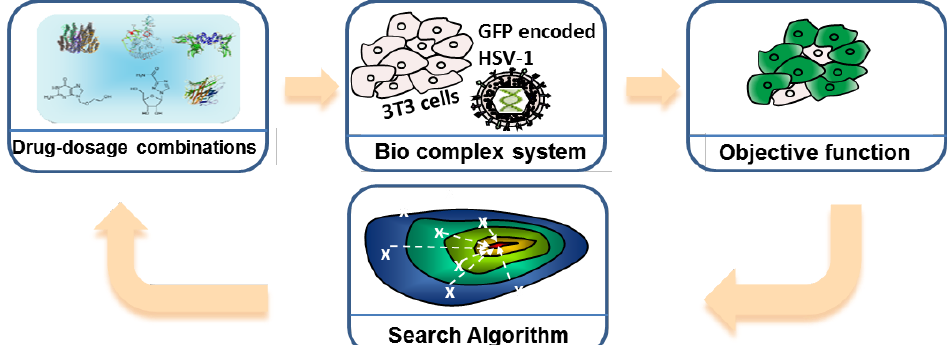
Figure 7. Feedback system control (FSC) scheme applied to the optimization of an Herpes Virus Simplex 1 (HSV-1) viral infection drug treatment. Drug combinations serve as the input stimuli for the biological complex system, the infected 3T3 cells; the virus attempts to infect normal cells, and the drug combinations try to inhibit virus infection. The objective function, or output, measures the efficiency of the drug combination. The search algorithm reads the output and suggests new drug combinations to be tested, and these combinations improve with each iteration, leading to fewer infected cells. Adapted with permission from [23,24], Copyright (2012) Ding et al. , publisher and licensee Dove Medical Press